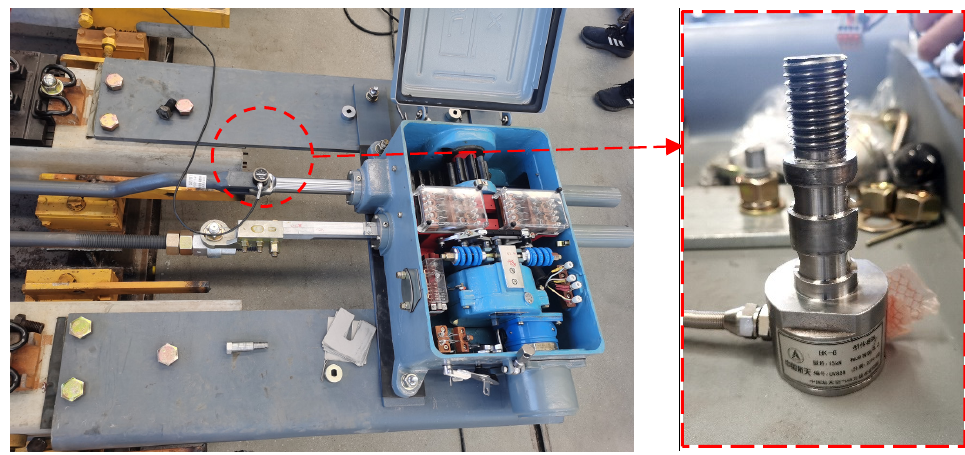
Figure 10. Switching force test.